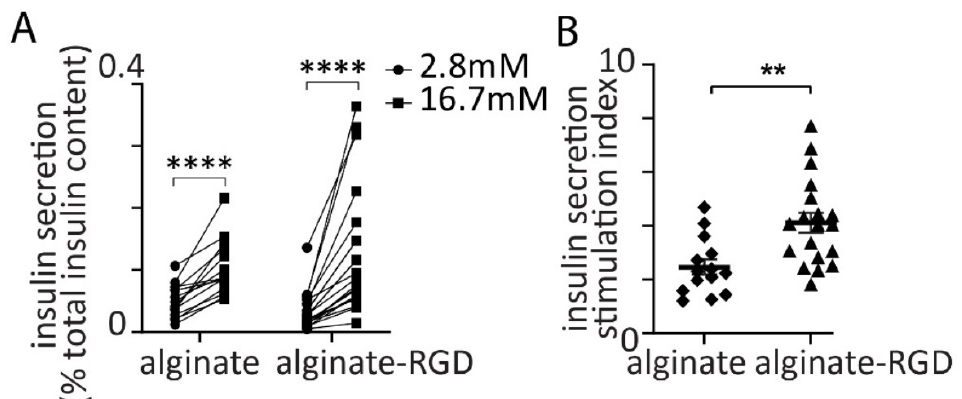
Figure 2. Embedding spheroids in alginate-RGD enhanced glucose-induced insulin secretion and polarised individual β cells. ( A ) A step increase in glucose from 2.8 mM to 16.7 mM induced a significant increase in insulin secretion from spheroids in alginate (n = 14 beads, Student t test p < 0.001, **** p < 0.001) and in alginate-RGD (n = 23 beads, Student t test p < 0.001). ( B ) A comparison of the insulin stimulation index (fold increase) in insulin secretion induced by high glucose showed a significant enhancement with the presence of RGD (Student t test p < 0.01, ** p < 0.01 ).